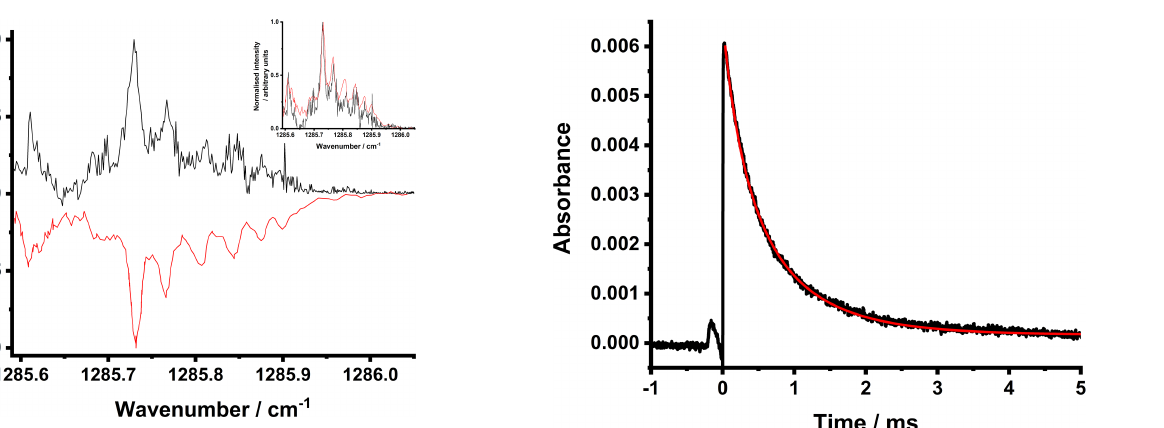
Figure 5. Time-resolved absorbance for CH 2 OO obtained at a wavenumber of ∼ 1285.73cm − 1 . Data are the average of 1000 photolysis shots at a total pressure of 50Torr. For these data, [CH 2 I 2 ] = 1.6 × 10 14 cm − 3 , and [SO 2 ] = 0. The fit to the data using the model containing the reactions given in Table 1 is shown by the solid red line, which gave k phys = (504 ± 40)s − 1 and l = (218 ±